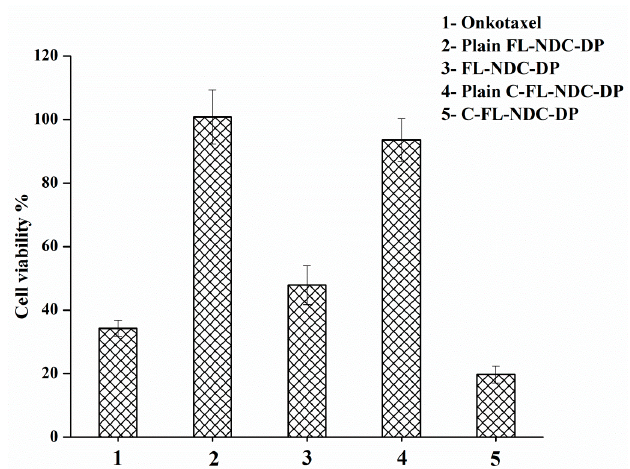
Figure 5. Cytotoxicity of DTX-loaded liposomes (FL-NDC-DP) and chitosomes (C-FL-NDC-DP) on the HT-29 cell line compared to Onkotaxel. The data are expressed as means ± SD, n = 3.